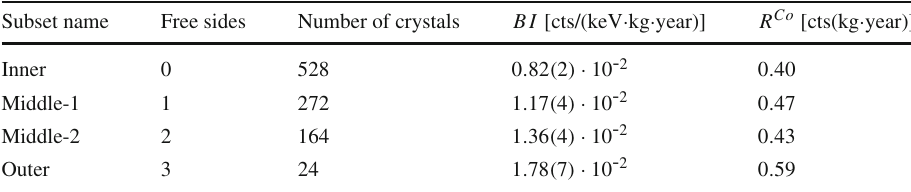
Table 2 Crystal subsets with different expected α background in CUORE. The values of BI and R Co are taken from [10]